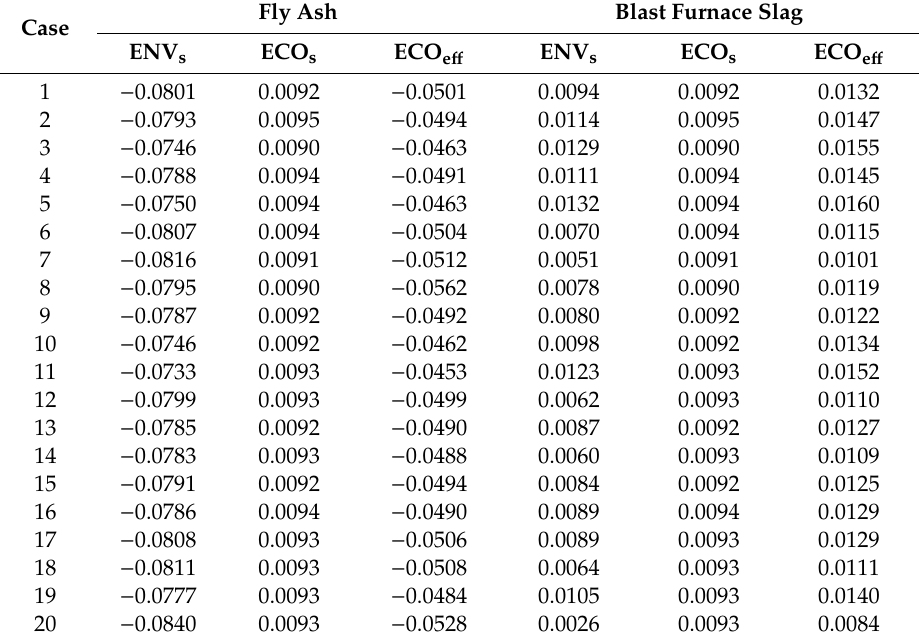
Table 2. Eco-e ffi ciency index of a single story reinforced concrete house (20